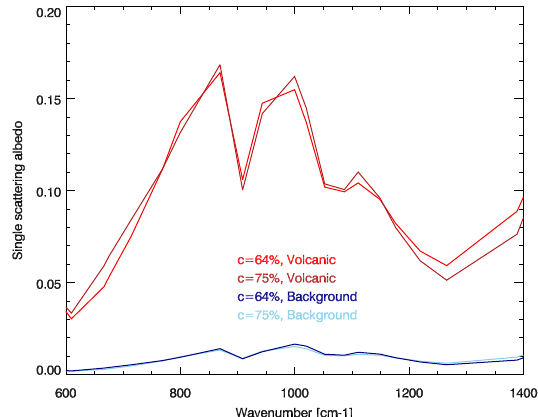
Figure 1. Spectral single scattering albedo, in the spectral range 600–1400cm − 1 , for sulfate aerosol layers with different H 2 SO 4 mixing ratios (64 and 75%, at 213–215K), for typical background size distribution (dark and light blue lines) and for a moderate vol- canically perturbed size distribution (dark and light red lines). See the text for further